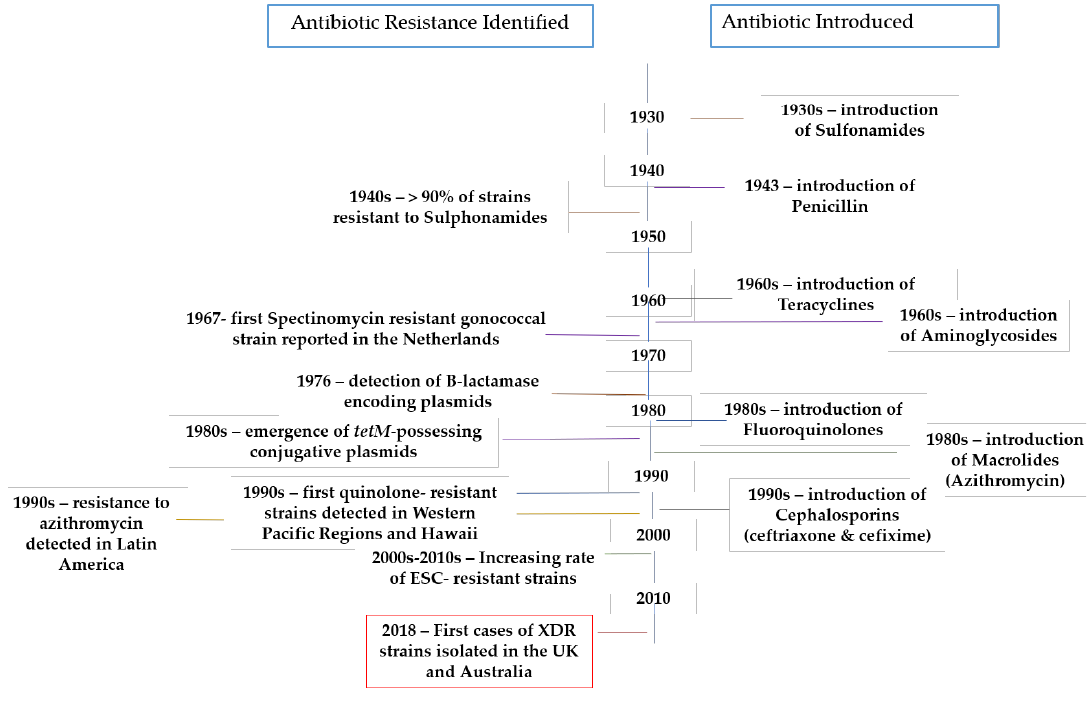
Figure 1. Timeline representing the introduction of treatments used against gonorrhea (right) and the first reports of resistance (left)